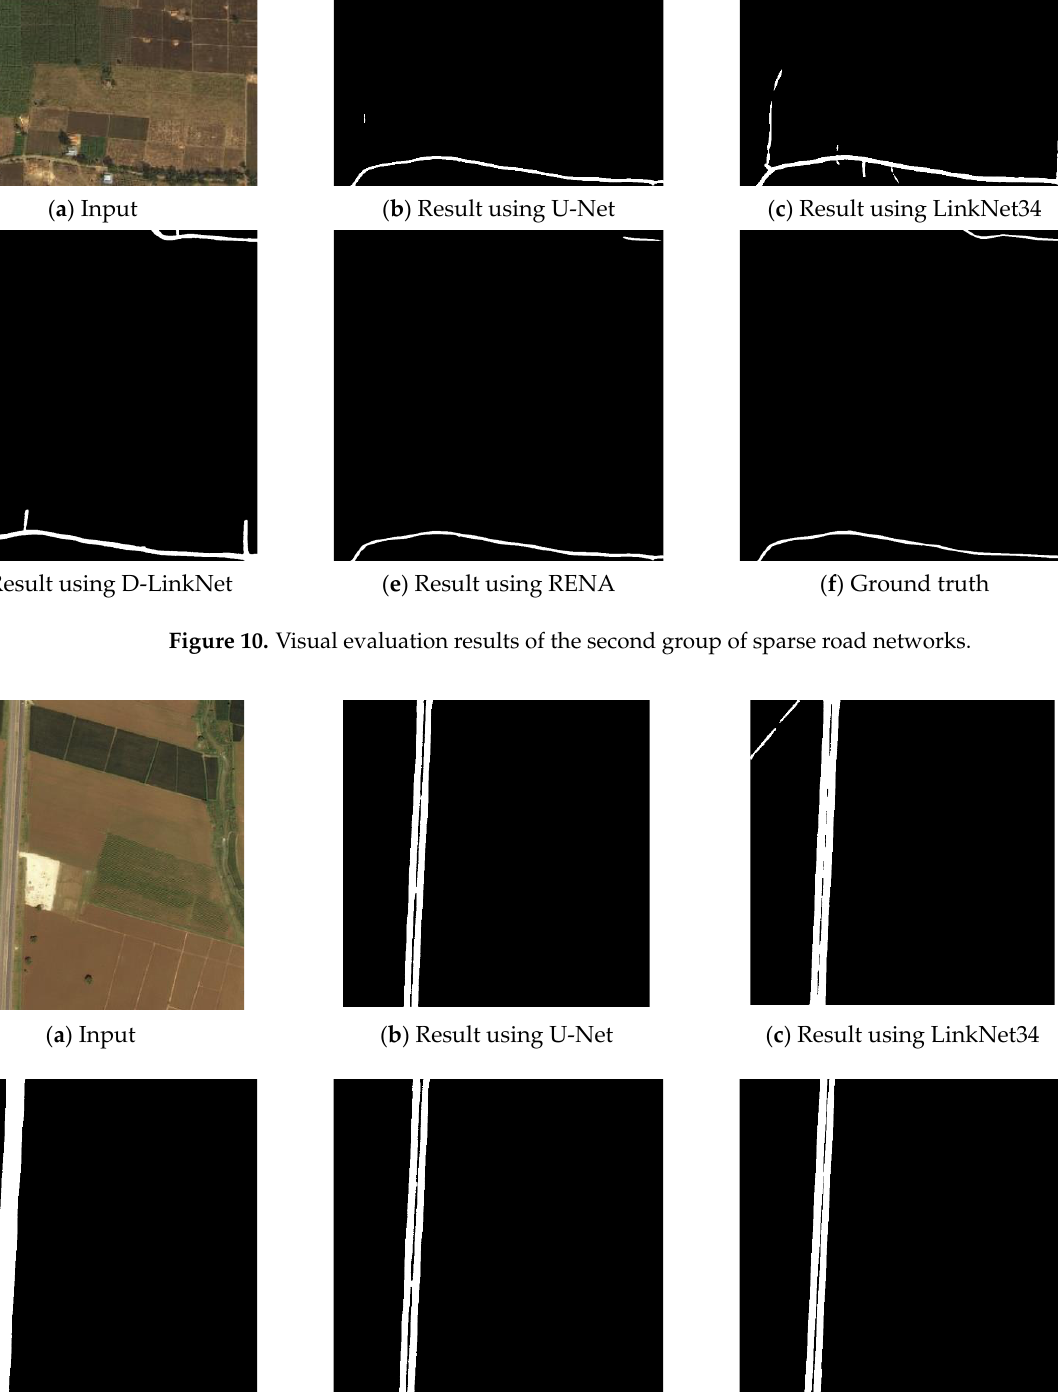
Figure 11. Visual evaluation results of the third group of sparse road networks. From the six sets of visual experiments in densely built-up areas and open areas, it